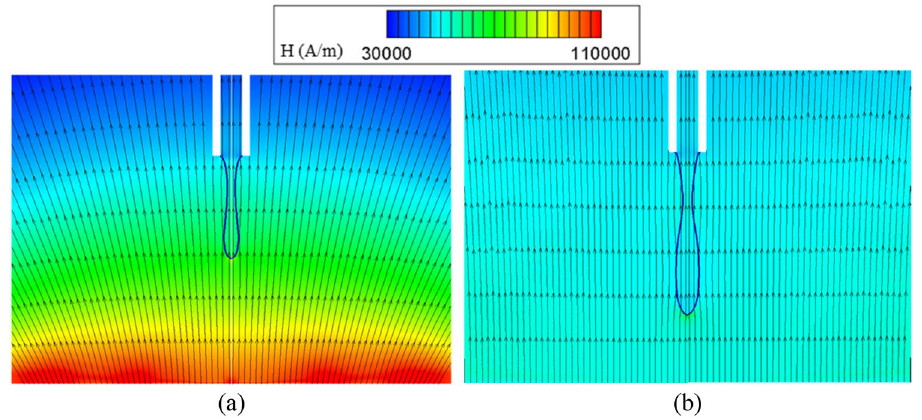
11 and ( b ) D core 44 for D N = N =